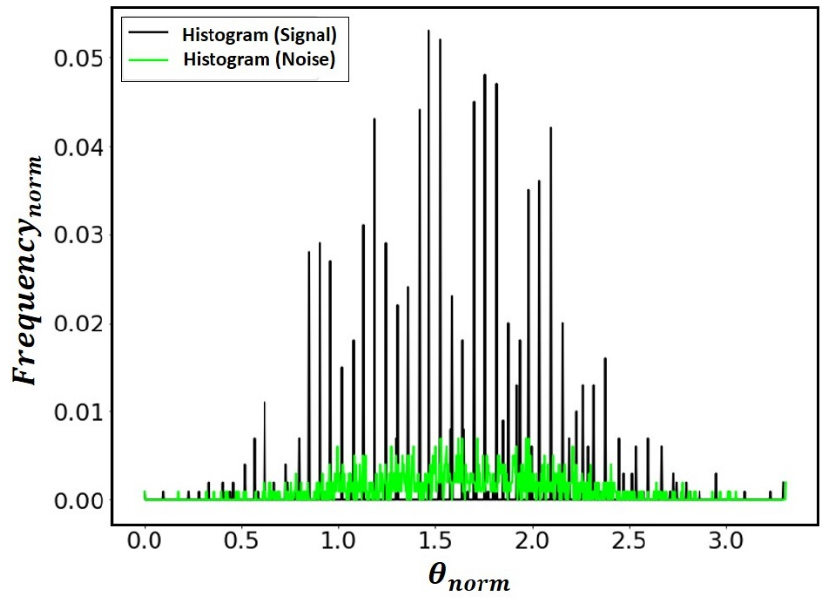
Figure 19. Normalized frequency histogram for estimating the probability distribution of the geomagnetic signal.